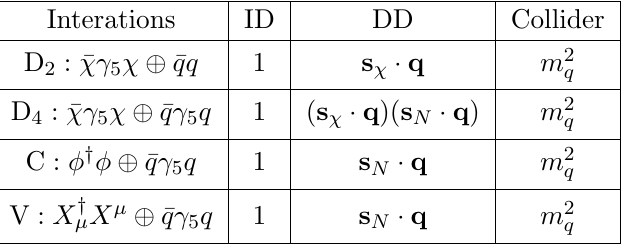
Table 1 . Interactions considered in this work and their suppression e(cid:11)ects for ID, DD and collider search. s (cid:31) ( s N ) is the spin of dark matter (the target nucleus) and q is the scattering momen- tum